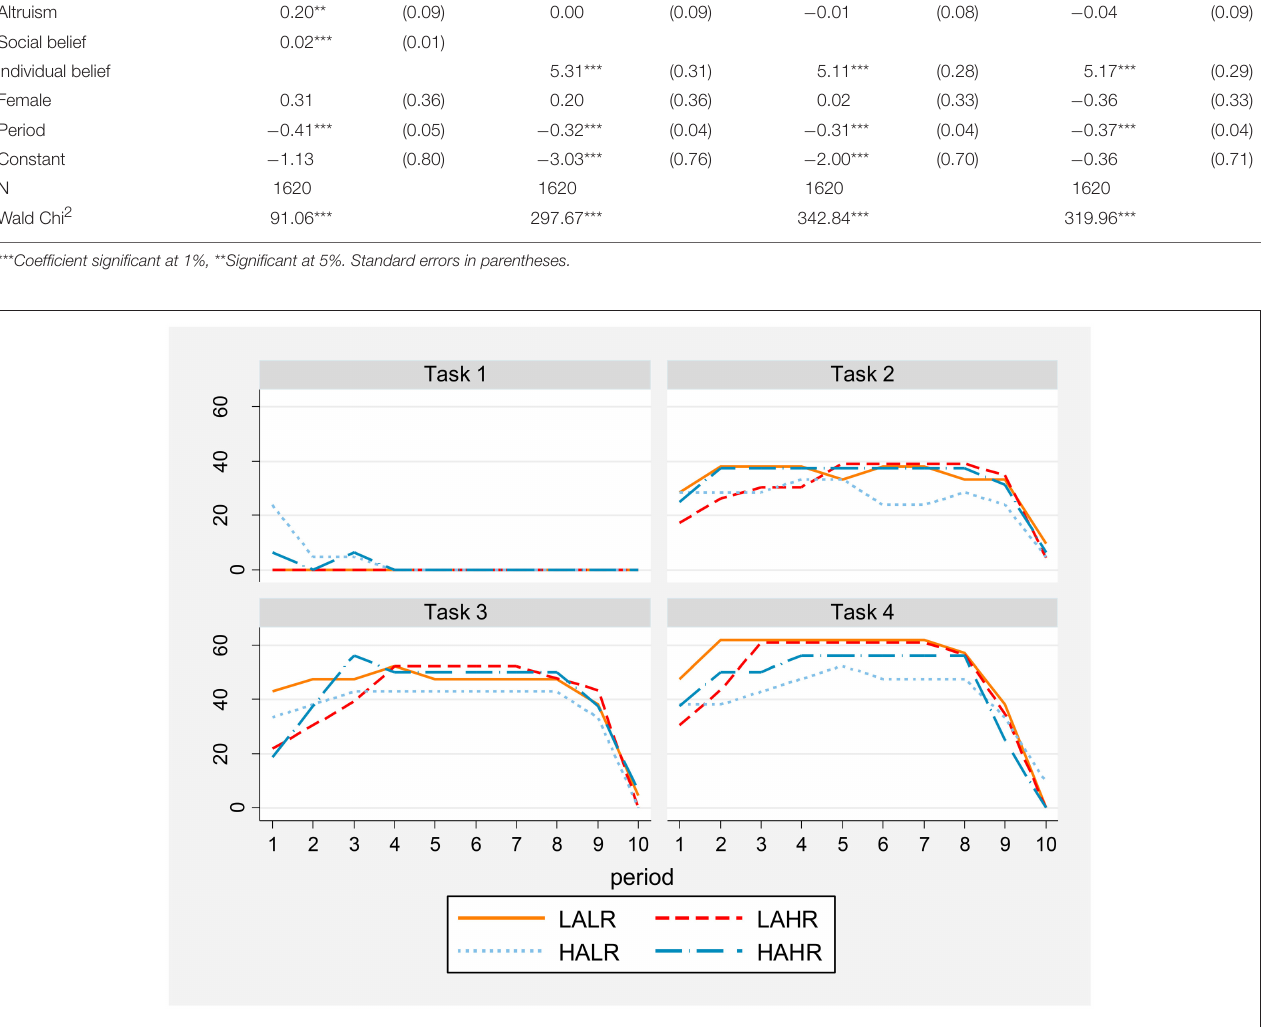
Material). There are no other treatment differences in reaching paired cooperation close to 40%, and task 4 reaches